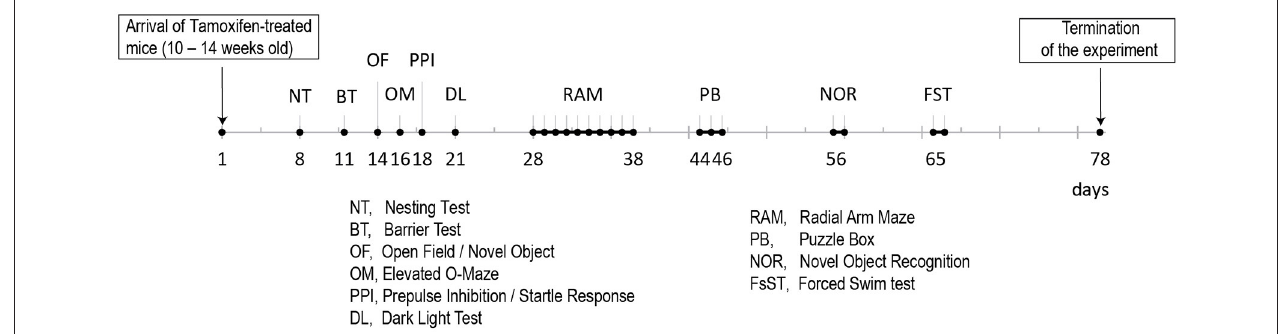
FIGURE 2 | Time line for the behavioral analyses of the two Tamoxifen treated cohorts (B6. Cg Erbb 4 tm 1.1( cre / ERT 2) Aibs / J /Gt(ROSA)26Sor tm 14( CAG − tdTomato ) Hze and control littermates).